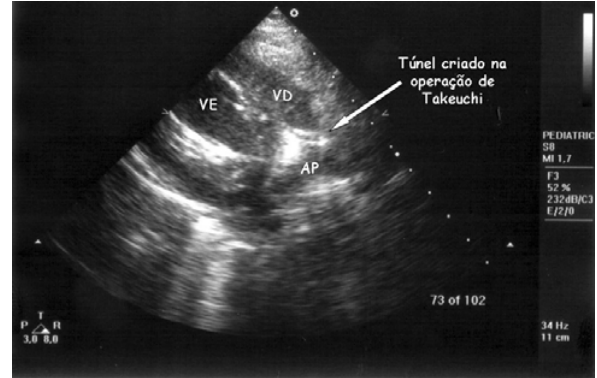
Fig. 3 – Ecocardiograma no 5º mês de pós-operatório com excelente fluxo da aorta para a coronária esquerda anômala.VE – ventrículo esquerdo, VD – ventrículo direito, AP – artéria